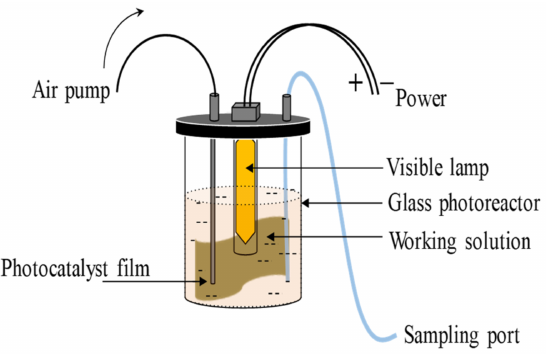
Figure 1. Schematic representation of the photocatalytic reactor setup for photocatalytic activity in a static mode.